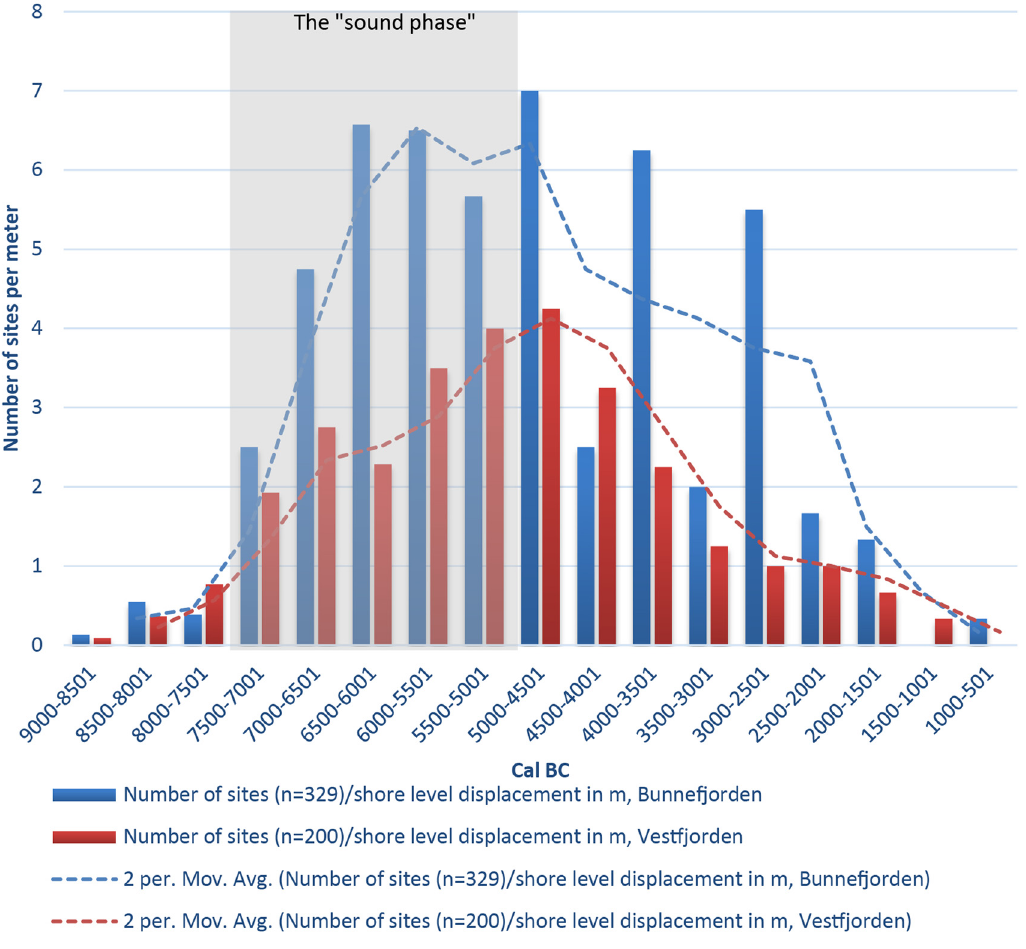
Figure 11: The number of sites in Vestfjorden and Bunnefjorden distributed in 500 year intervals and divided on the trans - gression rate in metres per